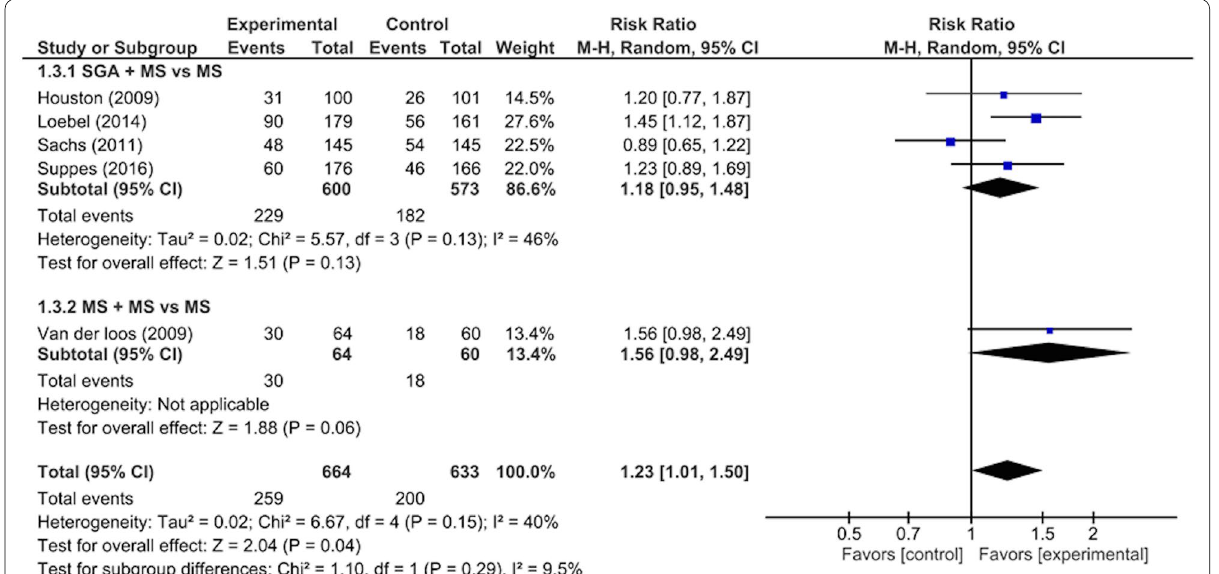
Fig. 3 Forest plot of post-intervention treatment effect sizes for remission rate from depressive symptoms. Subgroup analysis of types of combination therapy. CI, confidence interval; SD, standard deviation; MS, mood stabilizers, including lamotrigine, lithium, and valproate; SGA,